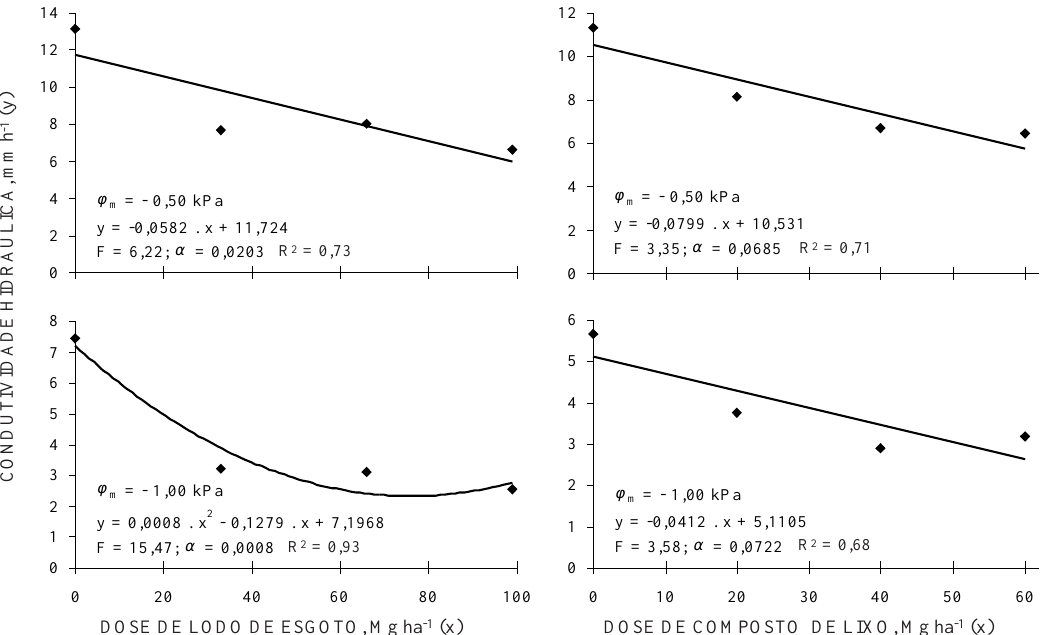
Figura 2. Valores médios para cada dose e funções ajustadas (obtidas na análise de variância a partir de 16 observações – 4 doses x 4 repetições), relacionando a condutividade hidráulica (K) com as doses de lodo de esgoto e de composto de lixo (com valor F e nível de probabilidade aaaaa ), para os potenciais mátricos onde houve significância, no primeiro ano do